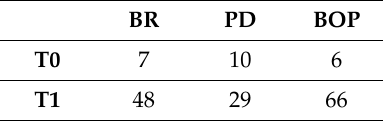
Table 3. Number of altered miRNAs as related to BR, PD and BOP recorded at the one-year (T0) and at the five-year follow-up (T1).